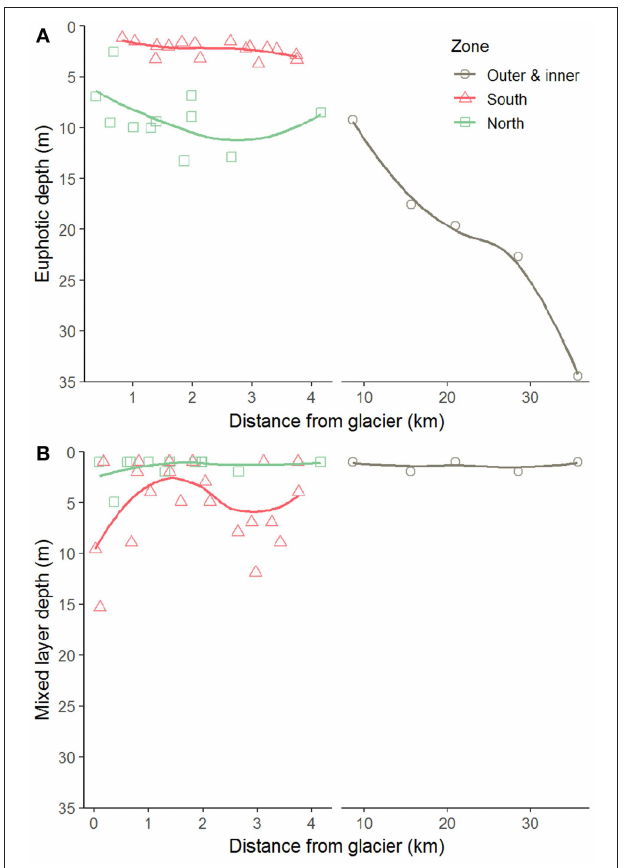
FIGURE 6 | Euphotic (A) and mixed layer (B) depths along transects perpendicular to the glacier fronts in Kongsfjorden. The thick line indicates local polynomial regression fit.